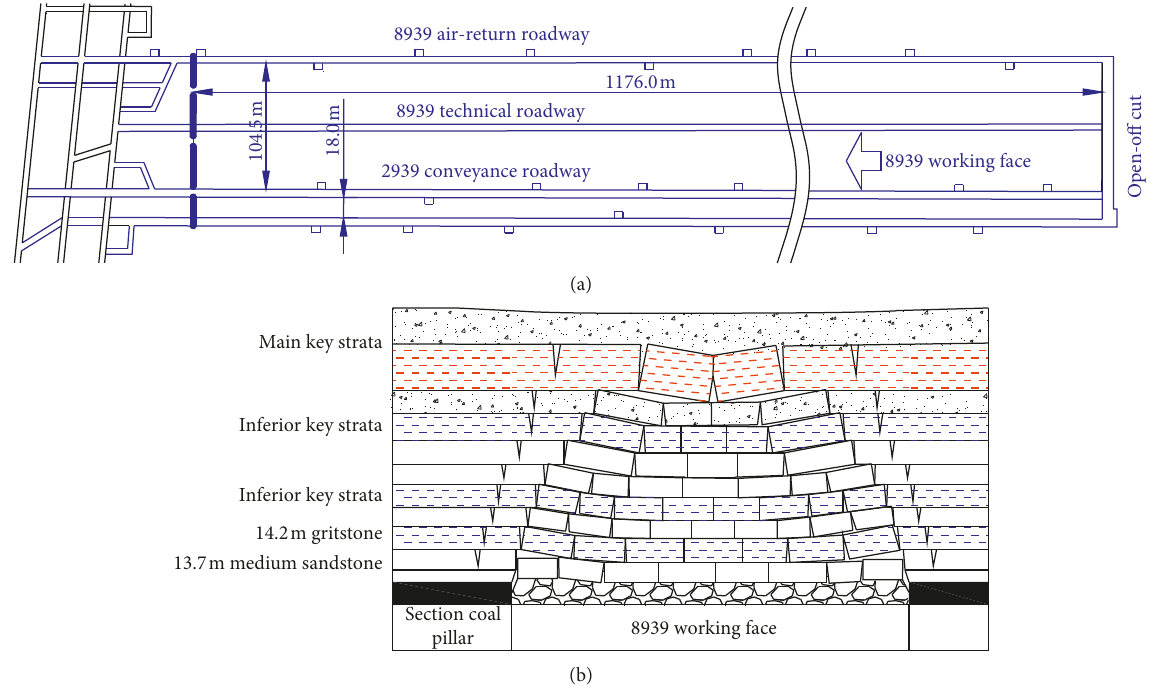
Figure 1: Location plan of 8939 working face. (a) Plane layout and (b) vertical section of the collapse.